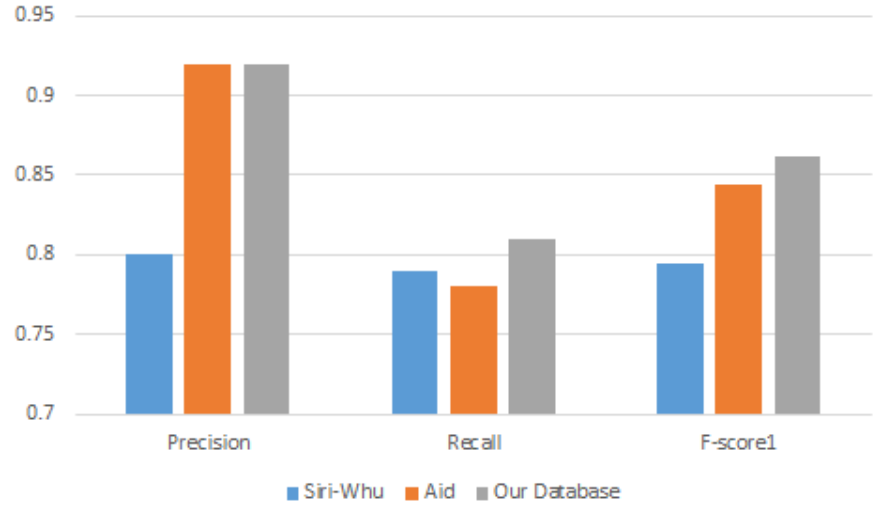
Figure 10. Results of our approach with UNet on Siri-Whu, Aid and our database.